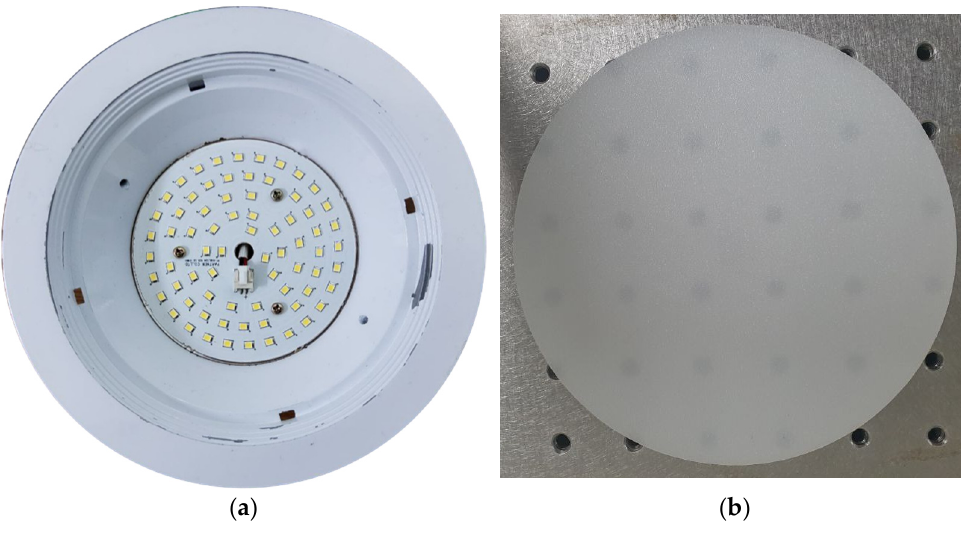
Figure 3. The photos of ( a ) the white LED lighting fixture and ( b ) the PC diffuser plate. Table 1. Dimensions and optical properties of the lighting frame and the PC diffuser plate.